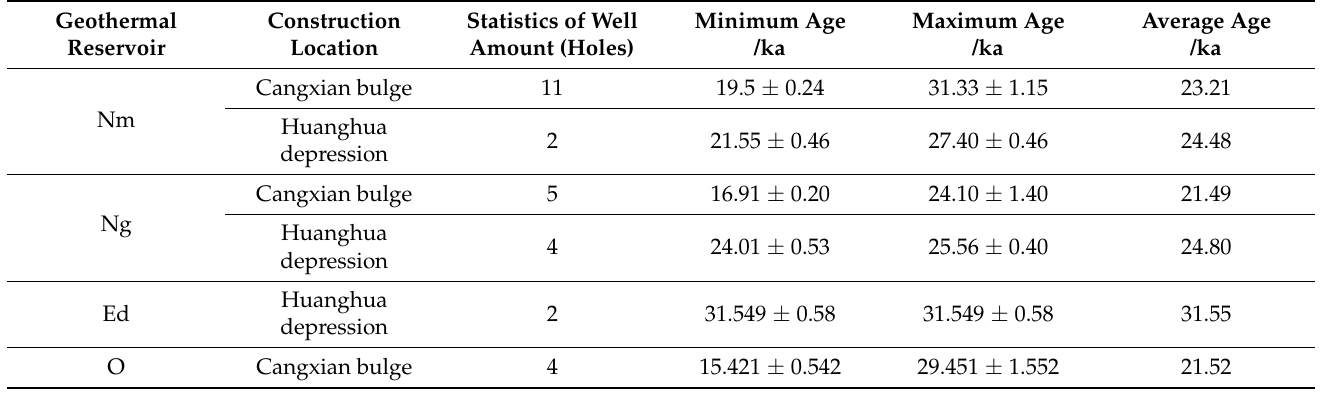
Table 8. Statistics table of the age data measure of the geothermal fluid in each geothermal reservoir.